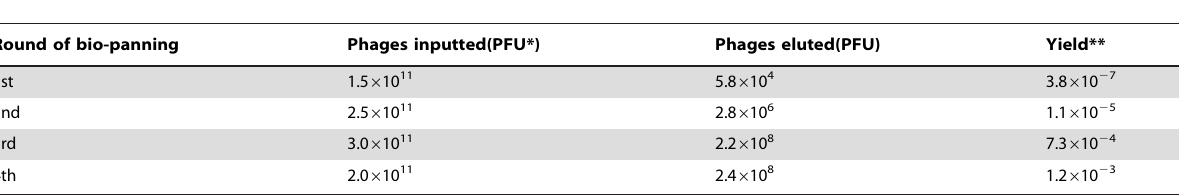
Table 1. Output Assay for Each Round of Plaque Selection.